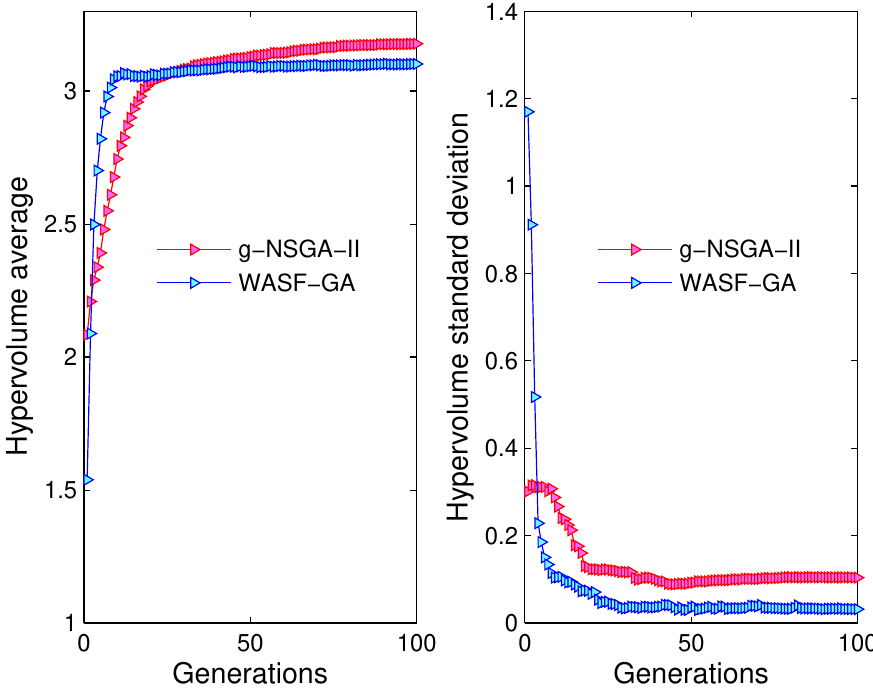
Figure 11. Evolution of the average hypervolume ( left ); and evolution of the standard deviation hypervolume ( right ) for g-NSGA-II, WASF-GA, DM’s partial-preferences ( 30,0.001 ) ( N = 100).